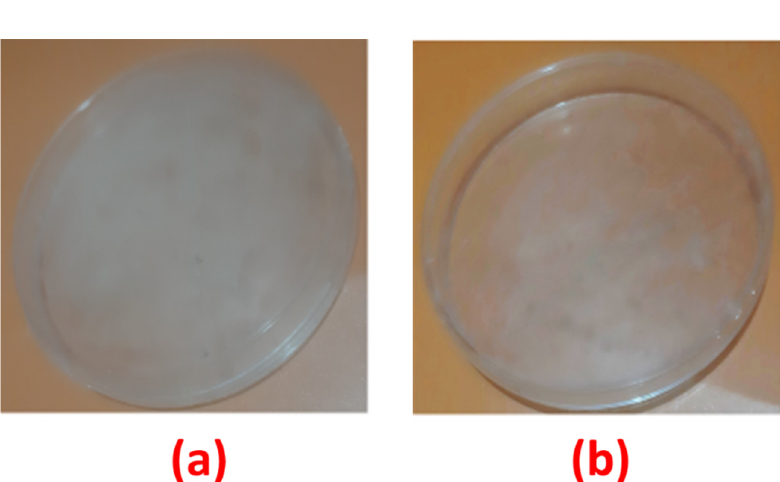
Figure 7. The effect of antifungal treatment on fabric samples: ( a ) sample without treatment; and ( b ) loaded with 1.5 mg of silver nanocomposites.